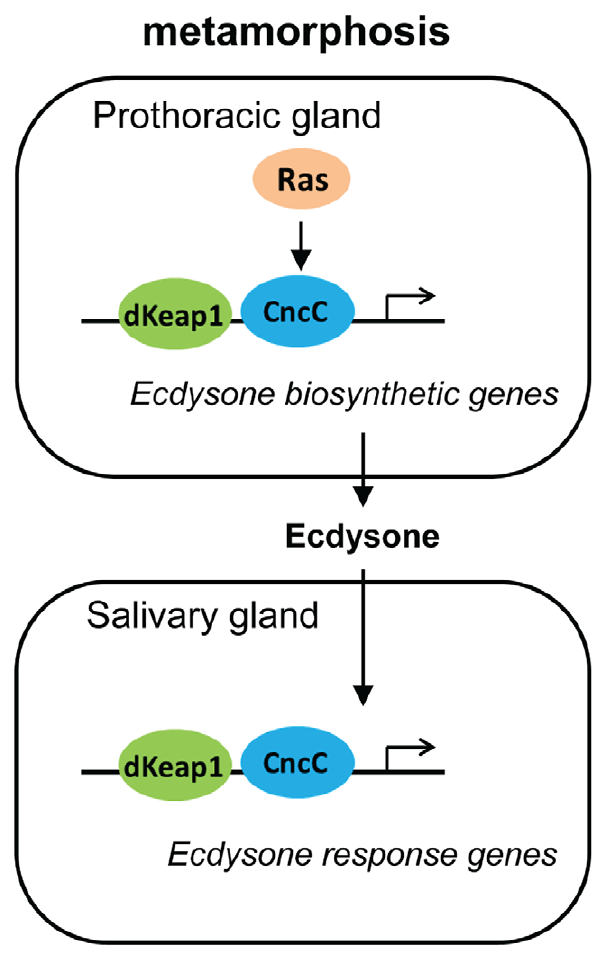
Figure 6. Model for the regulation of the onset of metamor- phosis by CncC and dKeap1. The roles of Ras signaling and ecdysone biosynthesis in the control of metamorphosis were previously established [17,18,19]. Our results show that CncC and dKeap1 regulate ecdysone biosynthetic genes and that CncC links Ras signaling to ecdysone biosynthetic gene transcription in the PG. The consequent modulation of ecdysone biosynthesis can regulate the onset of metamorphosis. CncC and dKeap1 also regulate the transcription of ecdysone-inducible genes in the salivary gland. We propose that CncC and dKeap1 coordinate the developmental programs that regulate the onset of metamorphosis by controlling both ecdysone biosynthetic and response genes in different